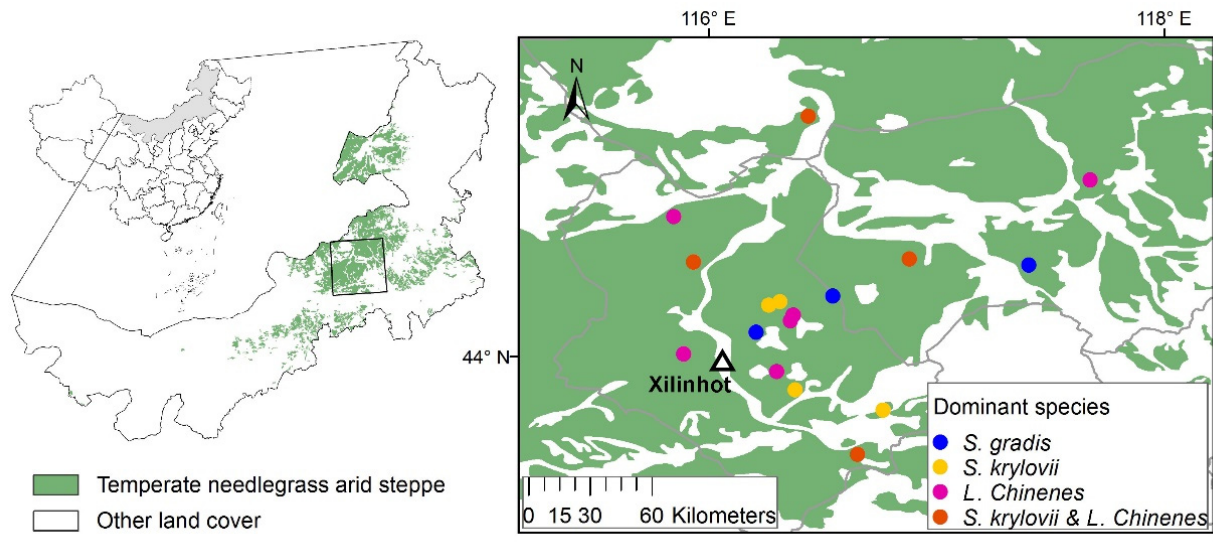
Figure 1. The study area of temperate grasslands in Xilingol region of IMAR, northern China. Sampling sites with different dominant species are indicated by different colors.